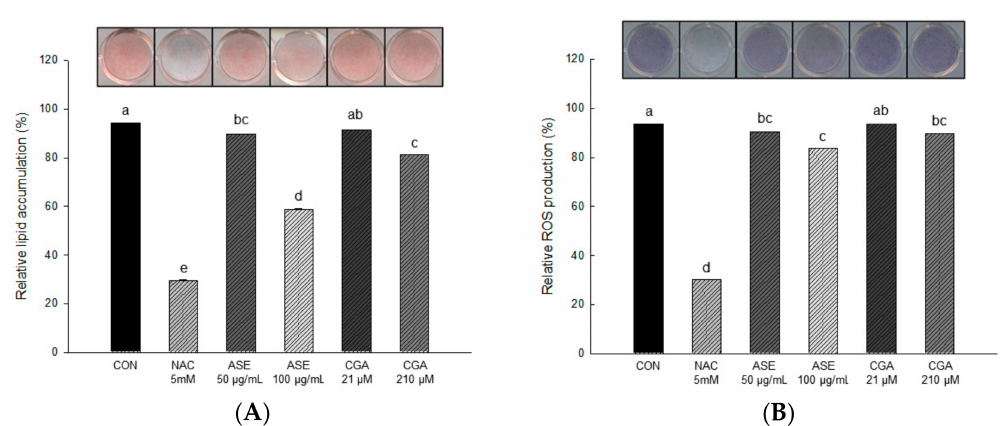
Figure 5. The e ff ect of ASE and CGA on lipid accumulation ( A ) and reactive oxygen species (ROS) production( B )in3T3-L1adipocyteduringtheadipogenesis. After6daysofMDItreatment, accumulated lipids were stained with oil red O (ORO) and absorbance was measured at 470 nm. ROS production was stained with nitroblue tetrazolium test (NBT) solution and absorbance was measured at 570 nm. Control group (CON), control cells which were di ff erentiated with MDI; N-acetyl-L-cysteine (NAC), positive control cells which di ff erentiated with MDI in the presence of NAC. Each value is expressed as the mean ± SD of triple determination. The other letters on the bars indicate a significant di ff erence of p < 0.05 in the Duncan multi-range test. a, c, d, e, ab and bc significant di ff erences among various parts of samples.